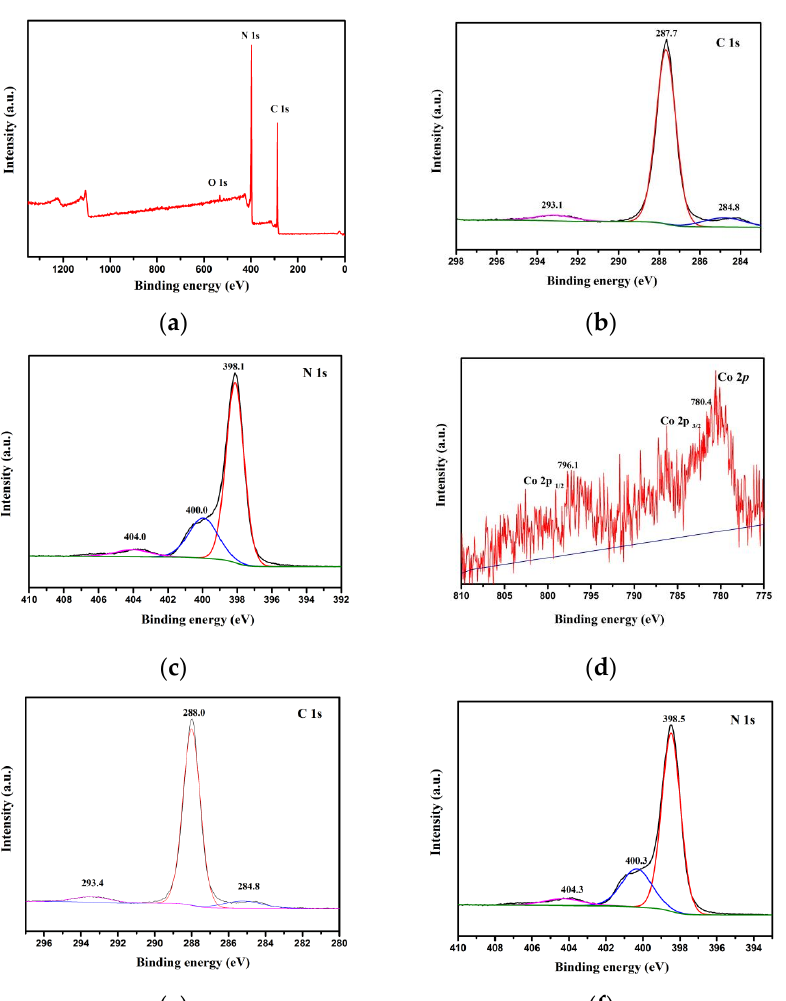
Figure 6. XPS spectra ( a – d ) survey, C 1s, N 1s and Co 2p of 0.5 % Co 3 O 4 /g-C 3 N 4 , ( e , f ) C 1s and N 1s of g-C 3 N 4 , respectively.